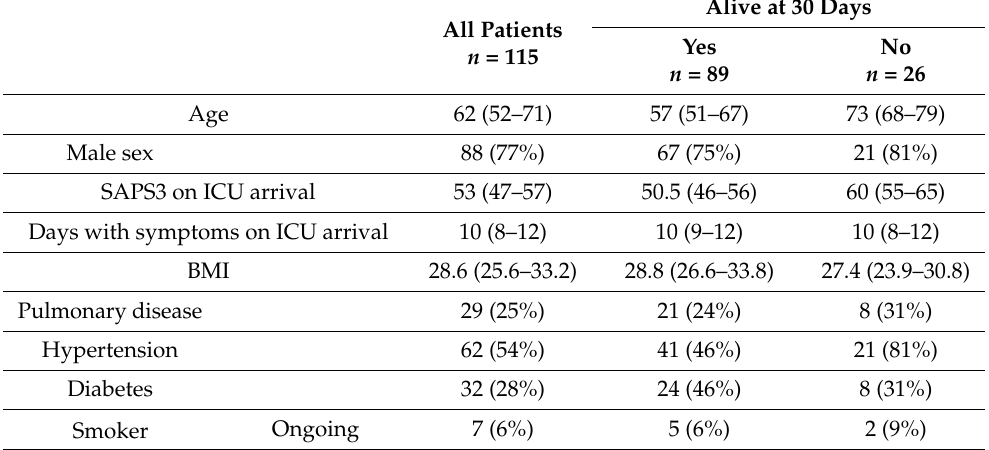
Table 1. Patient